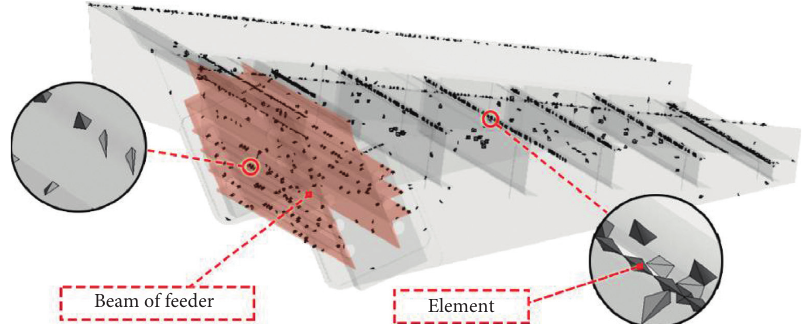
Figure 6: Meshes spatial distributions with the orthogonal quality coefficient of less than 0.25.